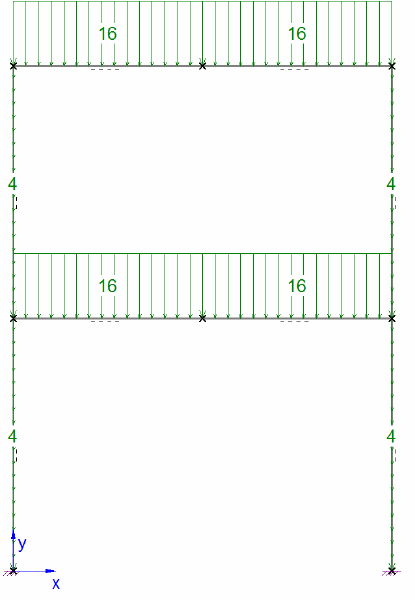
Figure 3. Vertical